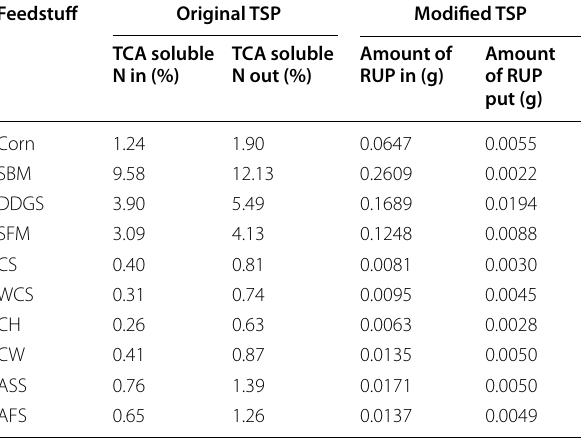
Table 2 RUP small intestine digestibility-related data